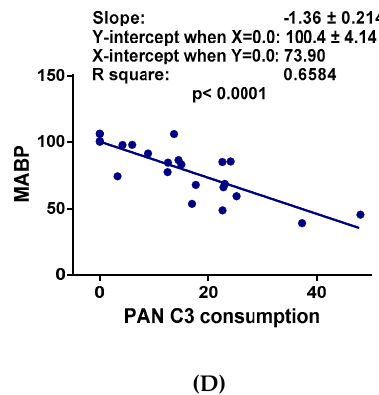
Figure 2. Blood pressure changes following in vivo administration of direct complement activators, amphotericin B-containing liposomes and empty vesicles. The doses and number of animals are specified in the keys; MABP, mean arterial blood pressure. ( A ) Effects of zymosan and cobra venom factor (CVF); ( B ) AmBisome at two doses; and ( C ) empty liposomes (AmBisombo at 2 doses and PEG-2000-chol). ( D ) Correlation between the lowest MABP and C3 consumption at the same time, including the data with CVF, zymosan, and AmBisome at both doses. Except for saline, CVF, and AmBisombo, the data in [17] were replotted with permission of the publisher. The data show percentages of change relative to baseline (t = 0 min), mean ± SEM. Statistical analysis was performed using two-way repeated measurements ANOVA followed by Dunnett’s multiple comparisons post-hoc test. Significant differences (* = p < 0.05; ** = p < 0.01; *** = p < 0.001) are shown relative to the group treated with